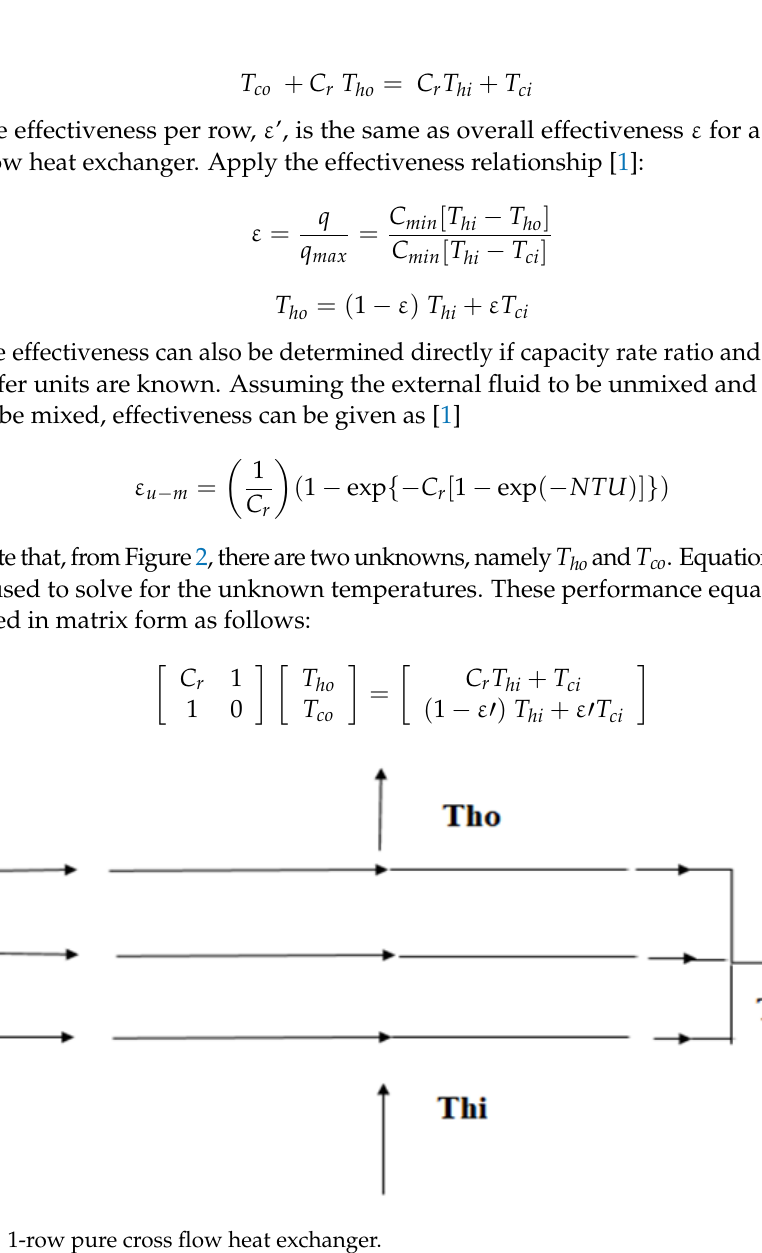
Figure 2. 1-row pure cross flow heat exchanger.